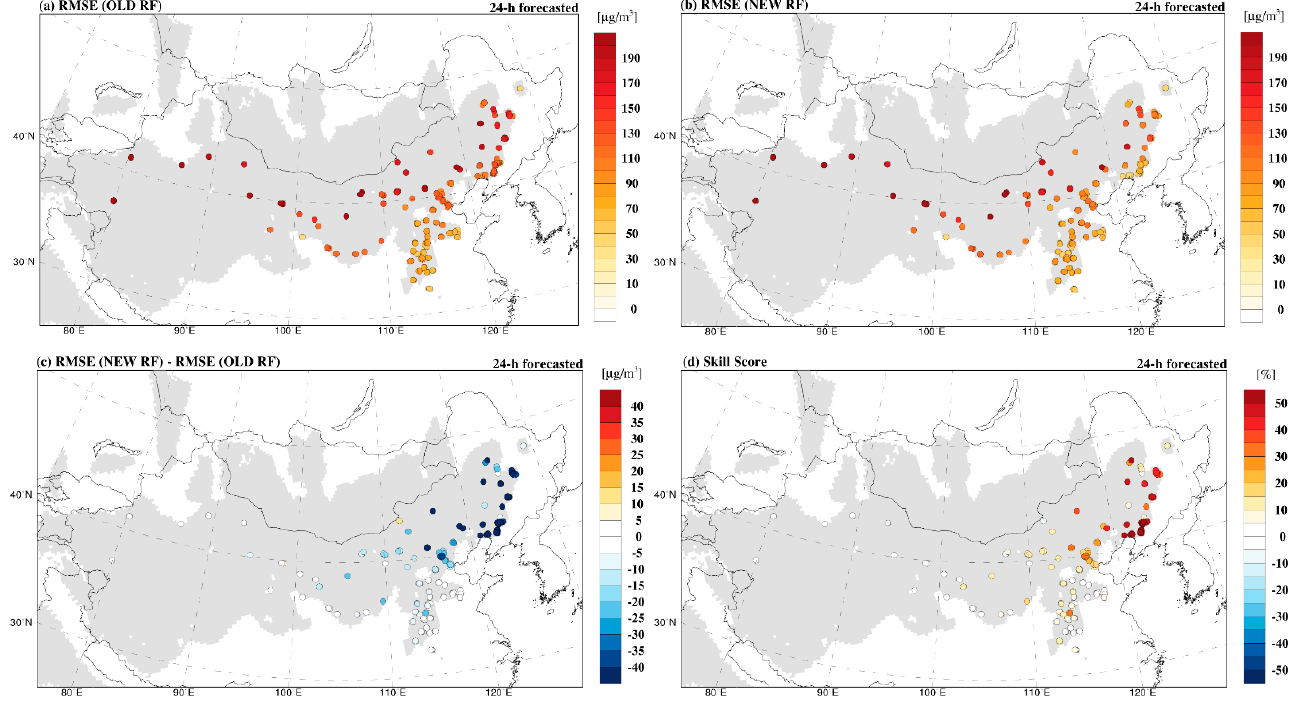
Figure 4. Spatial distribution of RMSE between predicted PM 10 and measured PM 10 for the ADAM3 performance with ( a ) OLD_RF and ( b ) NEW_RF. The circles designate 262 sites where PM 10 measurements were taken. ( c ) RMSE difference between RMSE (NEW_RF) and RMSE (OLD_RF) and ( d ) skill scores of the NEW_RF run compared with the OLD_RF run at the 24 h valid time.